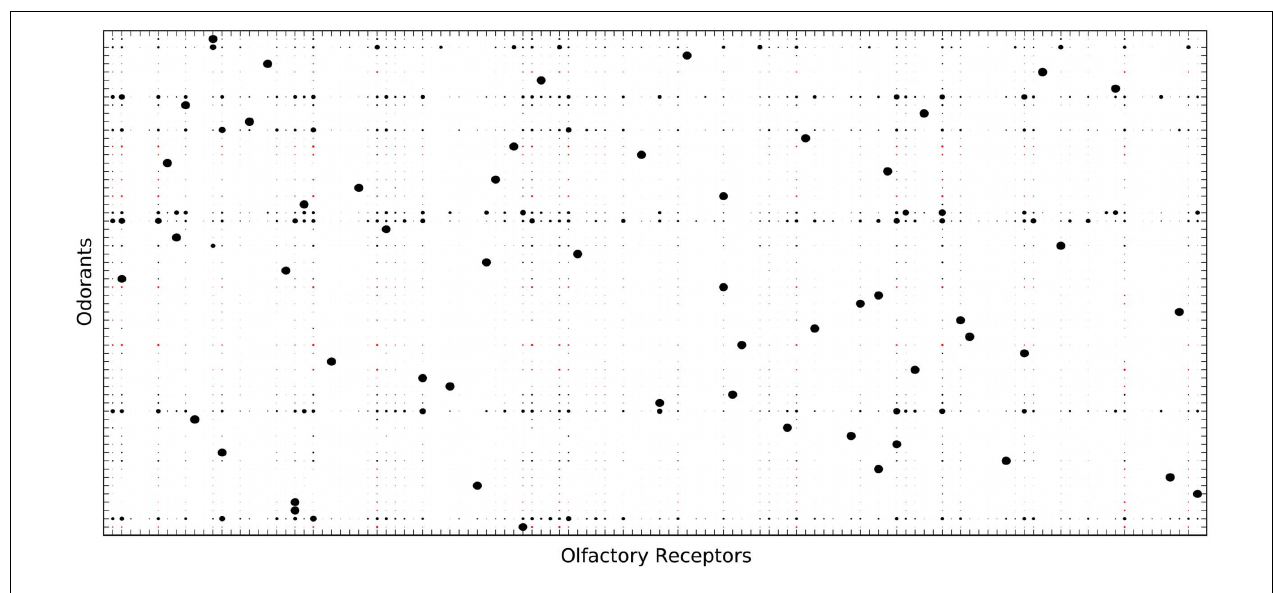
these ORs have the highest affinity. Affinity is indicated by the radii of the circles. Black circles stand for excitatory OR response, red circles stand for inhibitory responses.